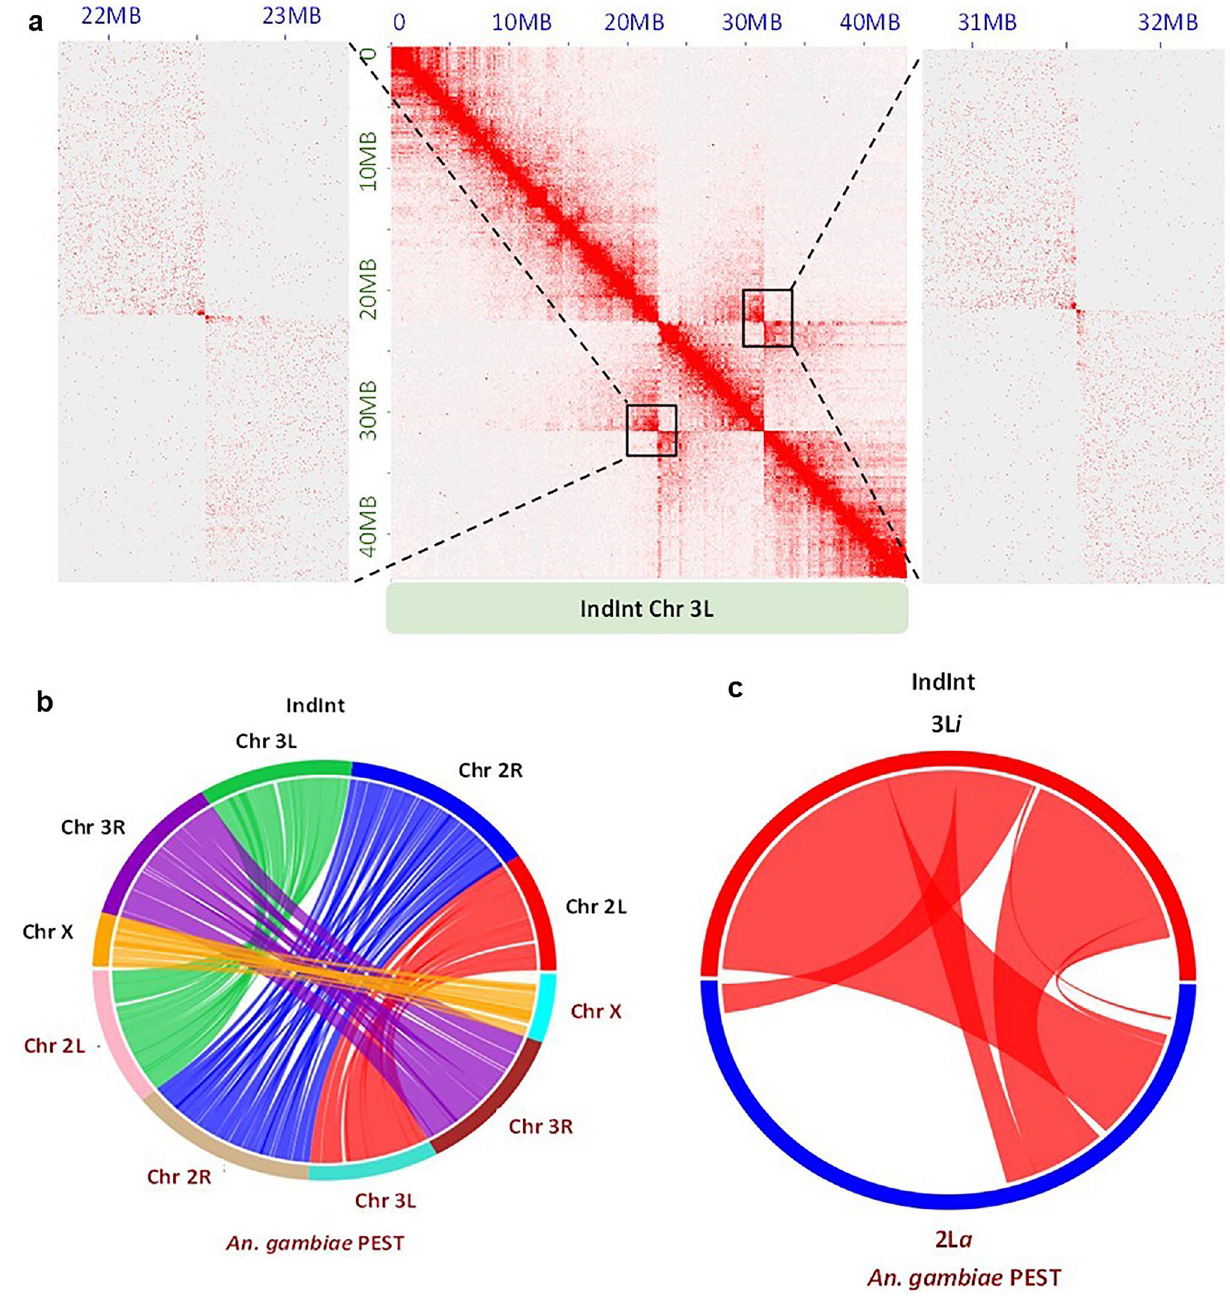
Figure 2. ( a ) Proximal and distal breakpoints obtained by mapping UCI HiC reads against the chromosome 3L of IndInt. The black boxes represent the centromere-proximal (left) and centromere-distal (right) breakpoints located between the ranges of bp 22,545,000 to 22,550,000 and bp 31,555,000 to 31,560,000, respectively, in the IndInt assembly. Adjacent to the contact map are the enlargements of the butterfly structures, for a resolution of 5 Kbp per dot. ( b ) Synteny between An. gambiae and IndInt assemblies. ( c ) Synteny between the An. gambiae 2L a and the IndInt 3L i